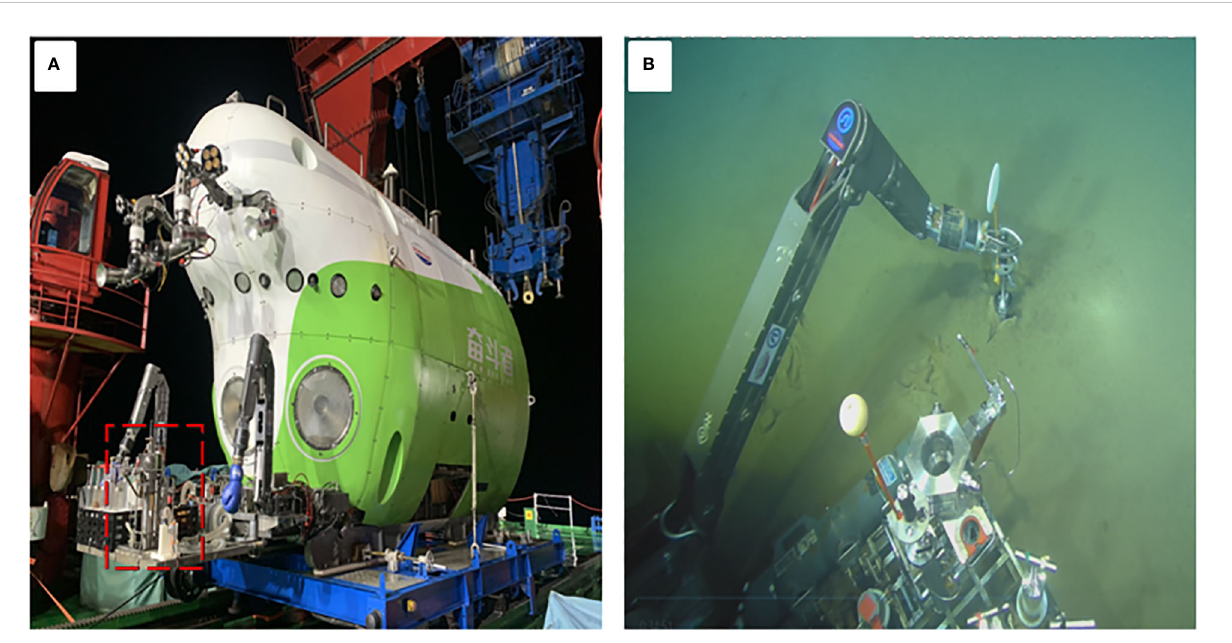
FIGURE 11 The scene of the sea trial, (A) the sampler was installed and fi xed in the tool basket, and (B) the sampling operations after the sampler reached the sampling site.